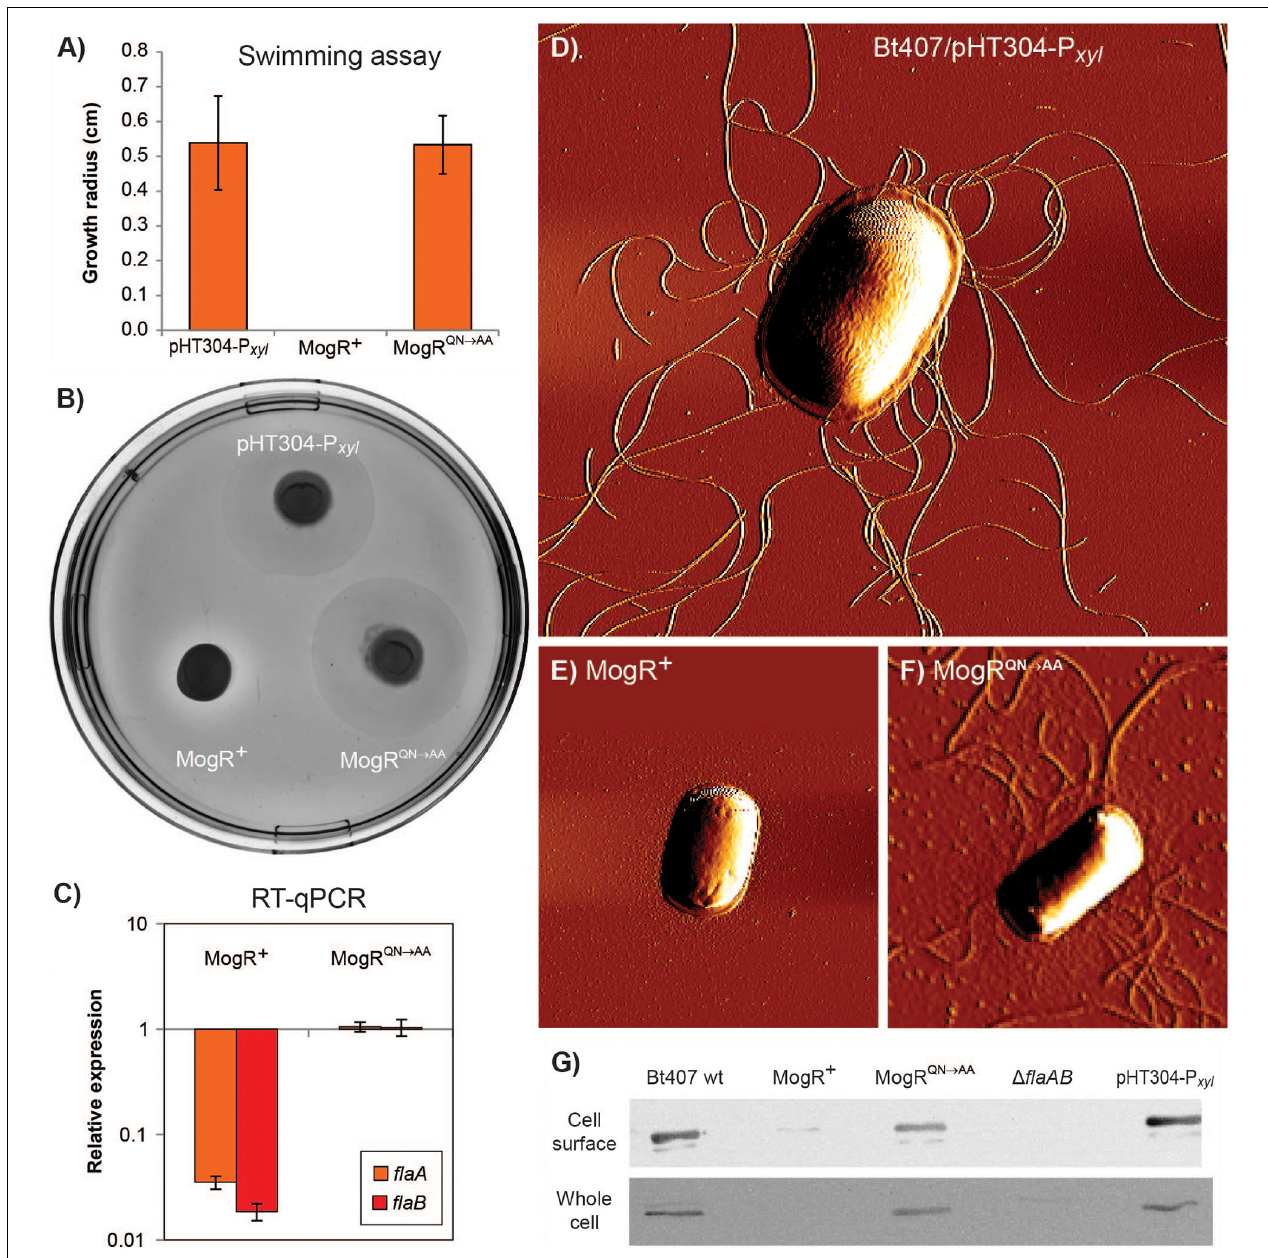
FIGURE 4 | Analysis of motility and expression of flagella upon MogR overexpression in B. thuringiensis 407. Assays were conducted using the following strains: B. thuringiensis 407 pHT304-P xyl empty vector control strain (pHT304-P xyl ); B. thuringiensis 407 pHT304-P xyl - mogR (MogR + ), overexpressing MogR; and B. thuringiensis 407 pHT304-P xyl - mogR QN → AA (MogR QN → AA ), overexpressing a mutated form of MogR (see Table 1 ). Expression was induced with 1 mM xylose and cells were grown at 30 ◦ C. (A,B) Swimming motility was determined following growth on 0.3% LB agar for 7 h. In (A) , the mean and corresponding standard error values obtained from three independent experiments are shown. (C) Gene expression analysis of flaA and flaB by RT-qPCR. The relative expression of flaA and flaB in the MogR or MogR QN → AA strains was normalized to the expression level of each respective gene in the empty vector control strain. Averages and standard errors of the means from three experiments are shown. (D,E,F) Atomic Force Microscopy images of bacterial cells grown to an OD 600 of 3. (G) Western immunoblots showing the level of flagellin protein present in cell surface and whole cell extracts. Here, the B. thuringiensis 407 wild type (wt) and B. thuringiensis 407 (cid:49) flaAB strains were included as